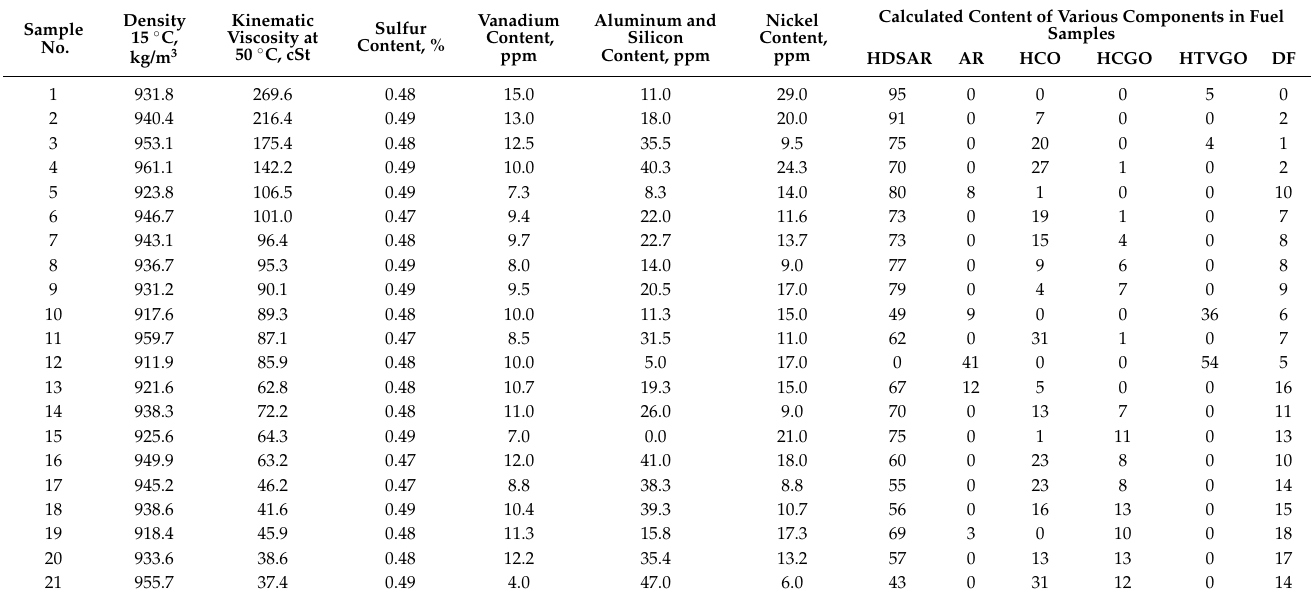
Table 2. Averaged batches of Singamas Petroleum marine fuels and the results of modeling their composition